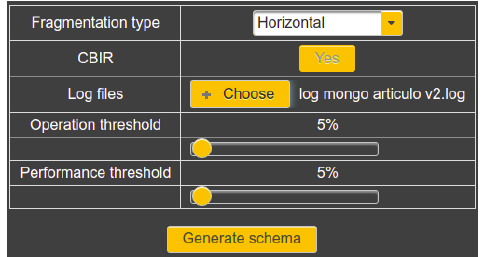
Figure 7. Configuration of the fragmentation to be performed.